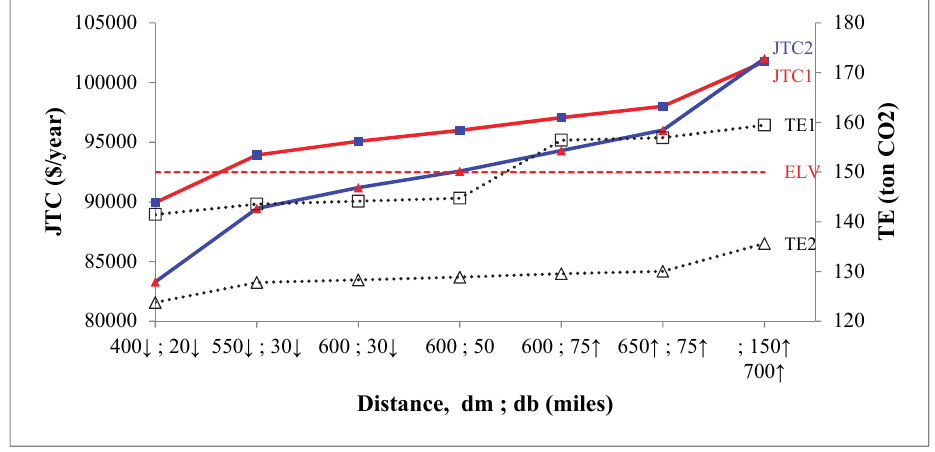
Fig. 13. Effect of changing in distance on total cost and total emission